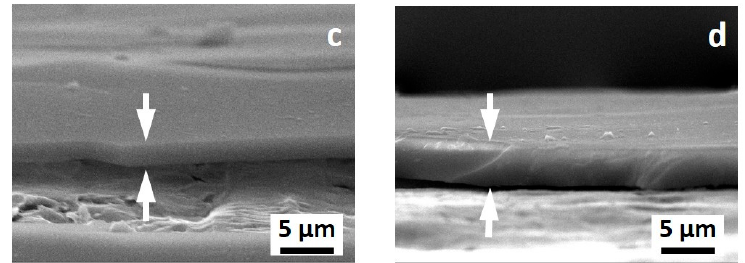
Figure 2. SEM images of the cross section of the investigated samples: PSZ-10 v / v % ( a ), PSZ-20 v / v % ( b ), PSZ-30 v / v % ( c ), and PSZ-40 v / v % ( d ). The arrows in each figure highlight the OPSZ coating.